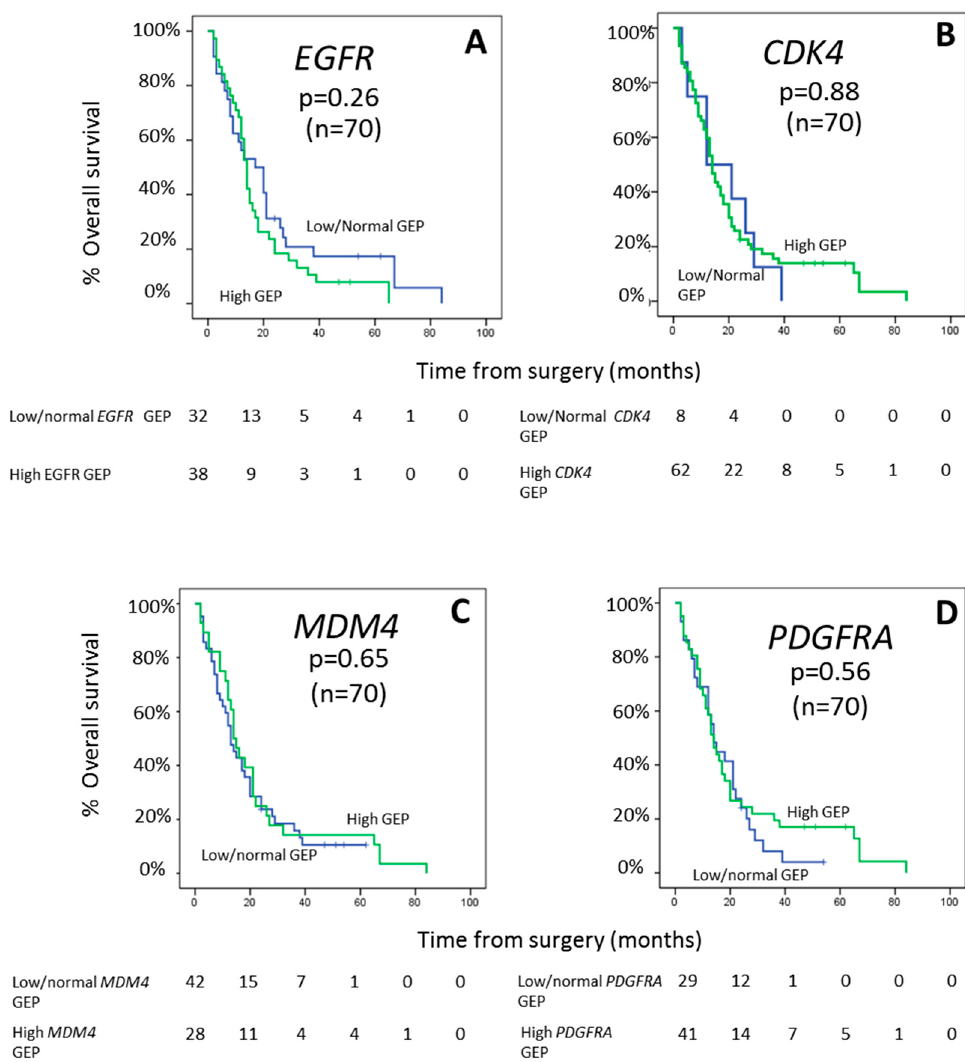
Figure 3. Prognostic impact of EGFR ( A ), CDK4 ( B ), MDM4 ( C ), and PDGFRA ( D ) GEP on overall survival of GBM patients.